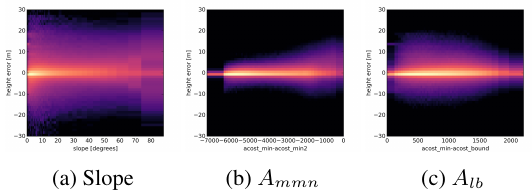
Figure 8: Height error vs. confidence variable joint histograms for the Pleiades Terrassa triplet. Color is proportional to the log- arithm of density of each joint histogram